Question: Write a single sentence explaining what this figure depicts.
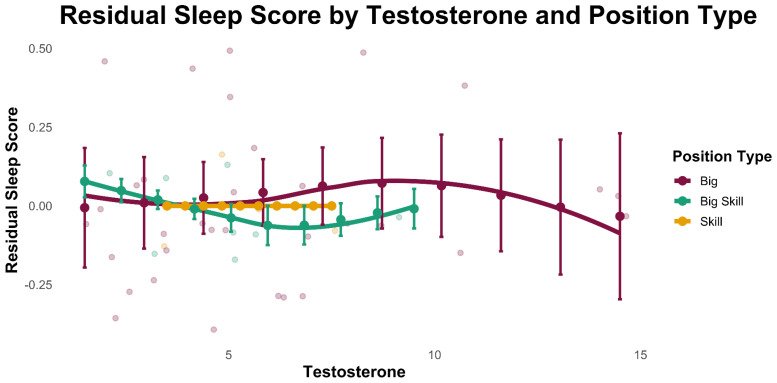
Answer: Residual sleep score by testosterone by position. Relationship between testosterone concentration and residual sleep scores across position types. Points represent individual observations, solid lines show LOESS-smoothed fits, and vertical whiskers denote 95% confidence intervals at sampled testosterone concentrations. Compared with skill and big-skill positions, players in big positions demonstrate greater variability in residual sleep across the testosterone range, as well as higher overall testosterone concentrations. Greater testosterone concentrations was associated with lower sleep quality in big skill athletes.